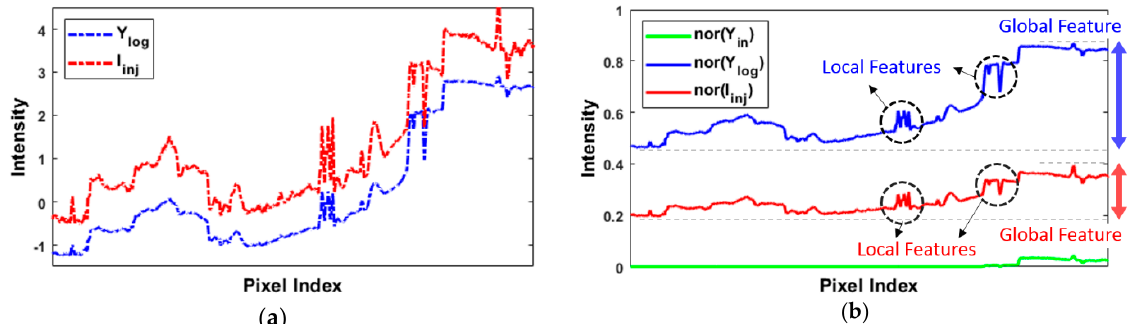
Figure 4. Comparison of the intensity distribution with (and without) the pre-processed detail enhancement along the line segment shown in the bottom right of Figure 1. ( a ) Before normalization. ( b ) After normalization. As shown in the red curve of ( b ), the goal of Section 3.2 was to preserve the local features as much as possible while normally compressing the global features.